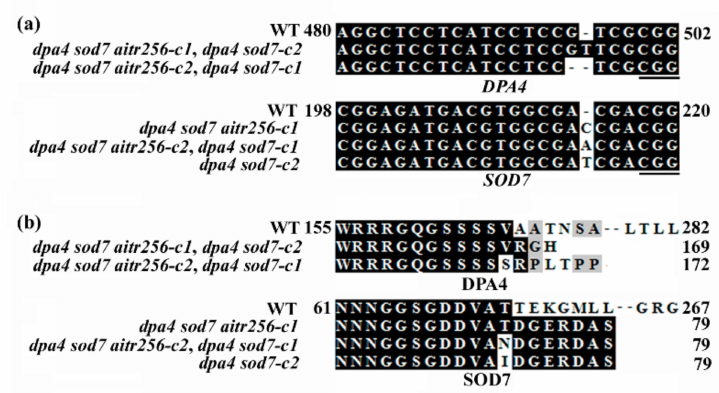
Figure 1. Generation of dpa4 sod7 aitr256 quintuple and dpa4 sod7 double mutants. ( a ) Alignment of CRISPR / Cas9 targeted nucleotide sequences of DPA4 and SOD7 in Col wild type and the dpa4 sod7 aitr256 quintuple and dpa4 sod7 double mutants. The mutants were obtained by transforming aitr256 triple mutant and Col wild type plants, respectively with DPA4 and SOD7 targeting pHEE construct, sequencing to examine the editing status in T1 generation, and selecting Cas9 -free homozygous mutants in T2 and / or T3 generations. Nucleotide numbers are relative to the start codon. Underlines indicate the PAM sites. ( b ) Alignment of the amino acid sequences of DPA4 and SOD7 in the Col wild type and dpa4 sod7 aitr256 quintuple and dpa4 sod7 double mutants. Coding sequences of DPA4 and SOD7 were subjected to ORF analysis by using ORFfinder (https: // www.ncbi.nlm.nih.gov / or ffi nder / ), and predicted amino acid sequences were used for alignment with the amino acid sequences of DPA4 and SOD7, respectively. Identical amino acids are shaded in black and similar in gray. Amino acid numbers are relative to the Met encoded by the start